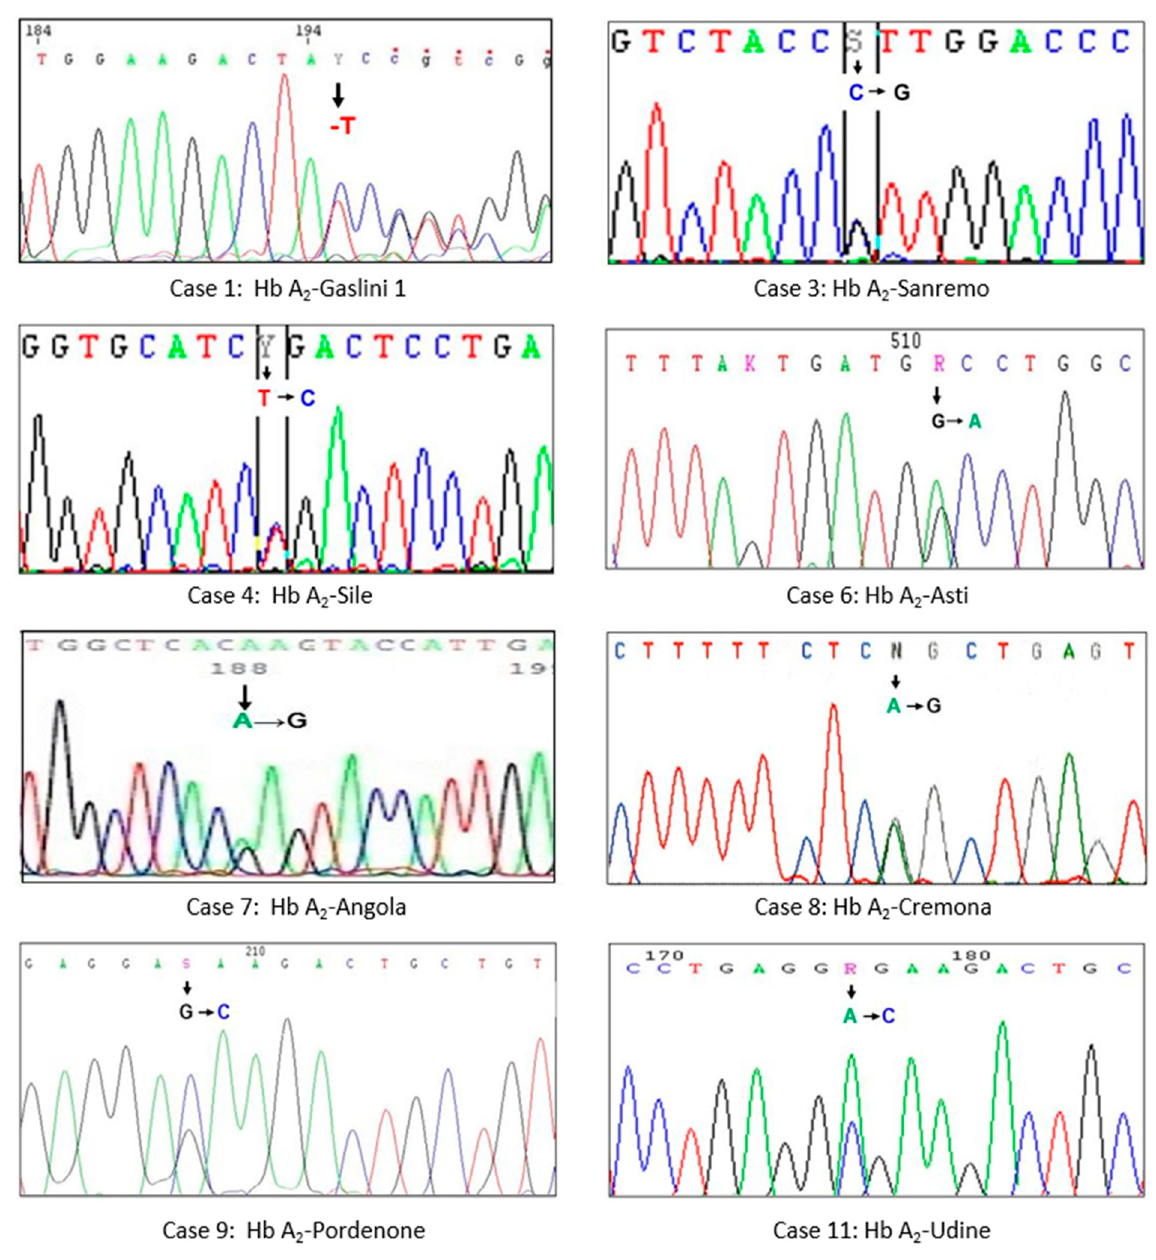
Figure 2. Parts of the DNA sequencing of the δ gene showing the substitutions of a single nucleotide (arrow) in the eight Hb A 2 characterized variants: the numbering of cases corresponds to that reported in Table 1.